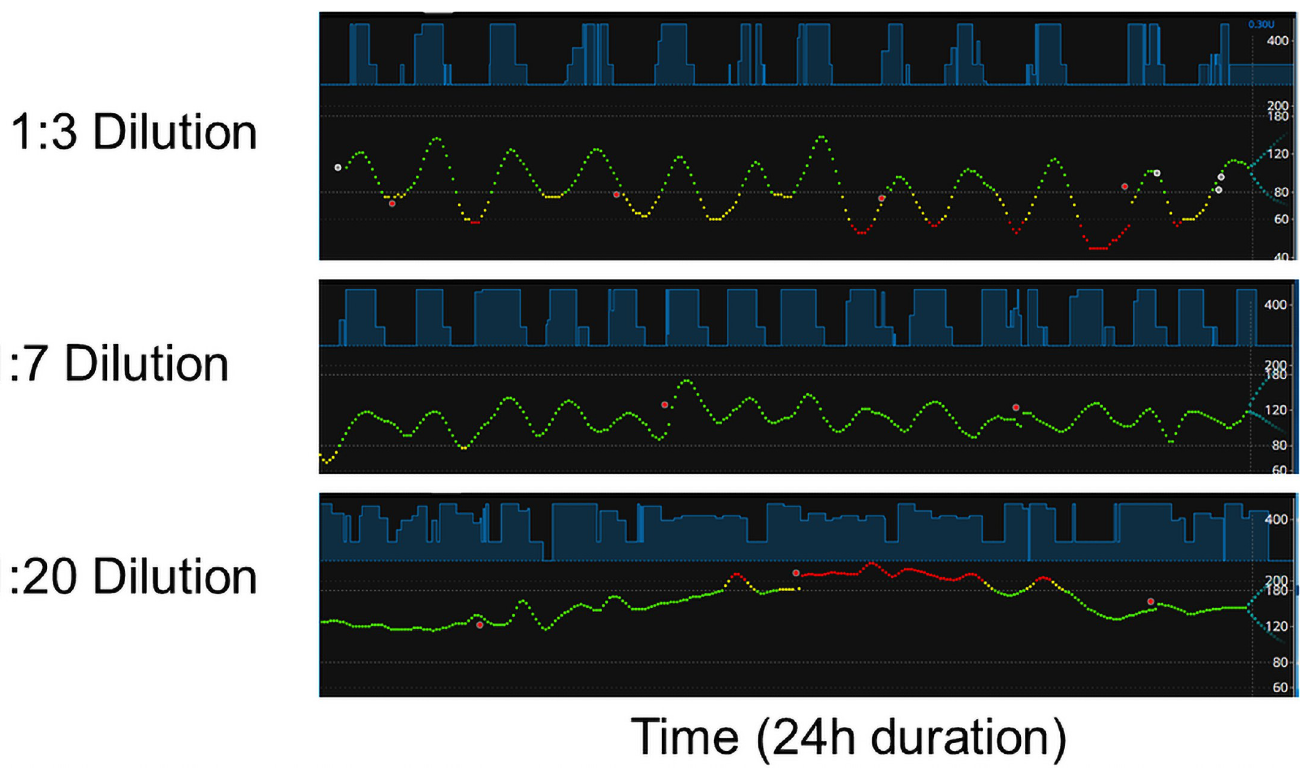
Fig 3. Determination of an optimal concentration of Humalog for diabetic rats. Representative Nightscout images of 1:3, 1:7, and 1:20 dilutions of Humalog are shown. OpenAPS controlled BGL was observed for the same diabetic rat using different dilutions of Humalog. Each individual experiment was run following the same procedure as described in the Methods section. A total of 20 independent experiments using 5 different diabetic rats and various dilutions of Humalog were performed.